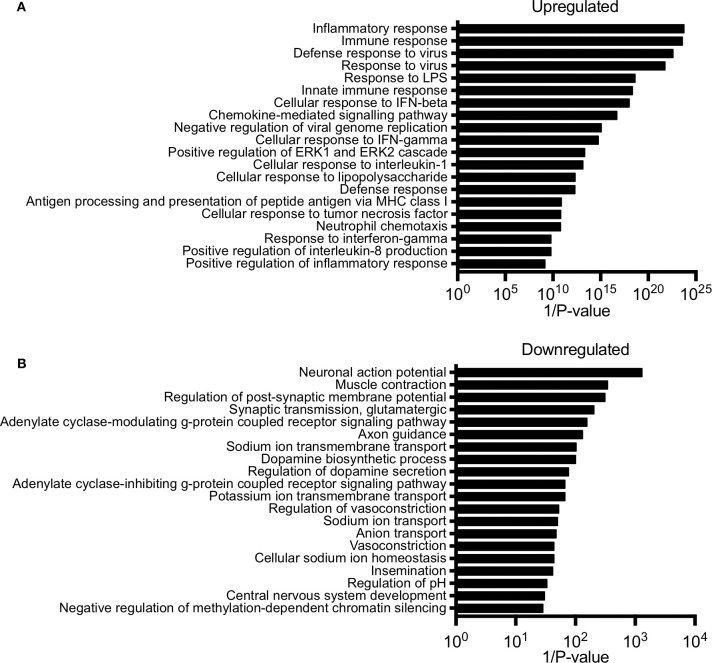
Pathway analysis of unique gene signatures upregulated and downregulated in the conceptus following maternal exposure to PolyI:C. (A) Top 20 gene pathways upregulated in the conceptus following administration of PolyI:C to pregnant dams. (B) Top 20 gene pathways downregulated in the conceptus following administration of PolyI:C to pregnant dams. Pathway analysis was conducted by inputting genes changed more than 2-fold compared to conceptuses collected following maternal exposure to saline, and with a false discovery rate < 0.01.